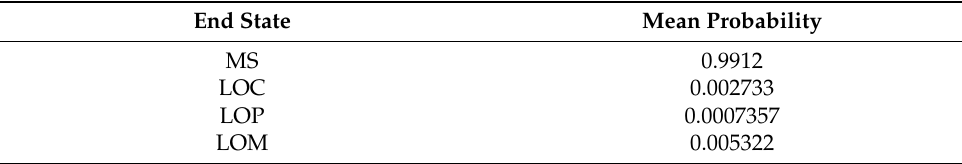
Table 7. Configuration mission reliability final states